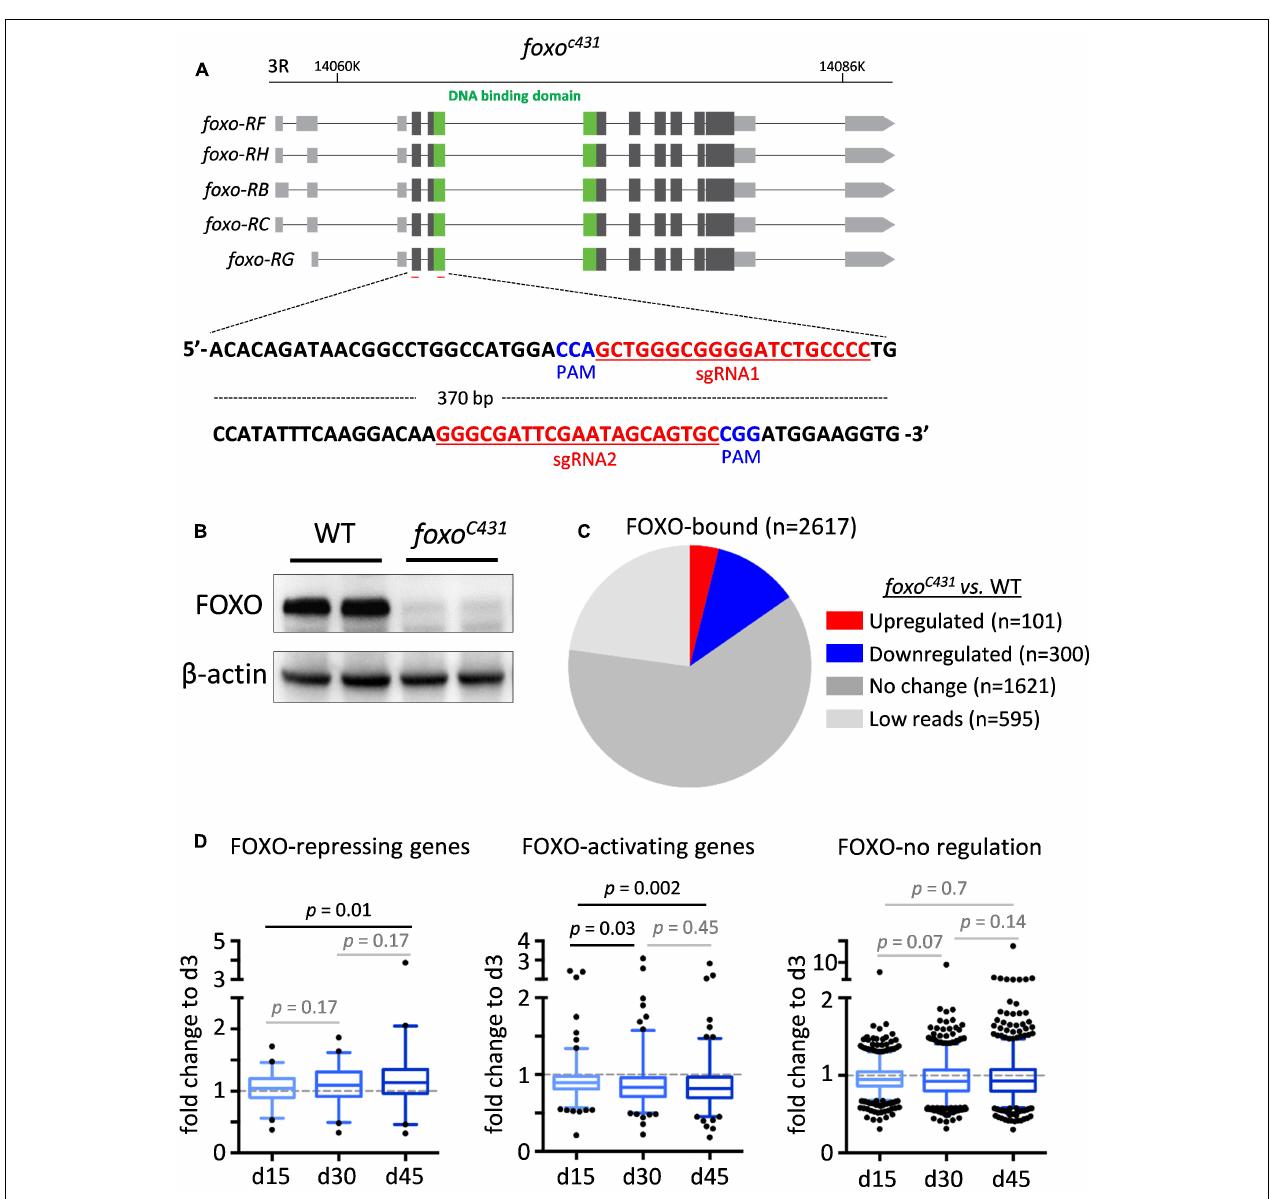
FIGURE 4 | The altered FOXO binding correlates with age-related transcriptional changes of FOXO targets in adult head tissue. (A) The diagram showing foxo locus and the target sites of the guiding RNAs (highlighted in red) used to generate foxo c 431 loss-of-function mutants by CRISPR/Cas9 mutagenesis. PAM: Protospacer adjacent motifs (highlighted in blue). (B) Western blots to verify the expression of FOXO proteins in foxo c 431 loss-of-function mutants. β -actin as a loading control. (C) The number of FOXO target genes that are differentially expressed between foxo c 431 mutants and wild-type flies. (D) Age-dependent transcriptional changes of FOXO target genes. Boxplots represent the mean fold change of genes at Day 15 (d15), Day 30 (d30) and Day 45 (d45), relative to that of Day 3 (d3) in aging head tissue (Student t -test).